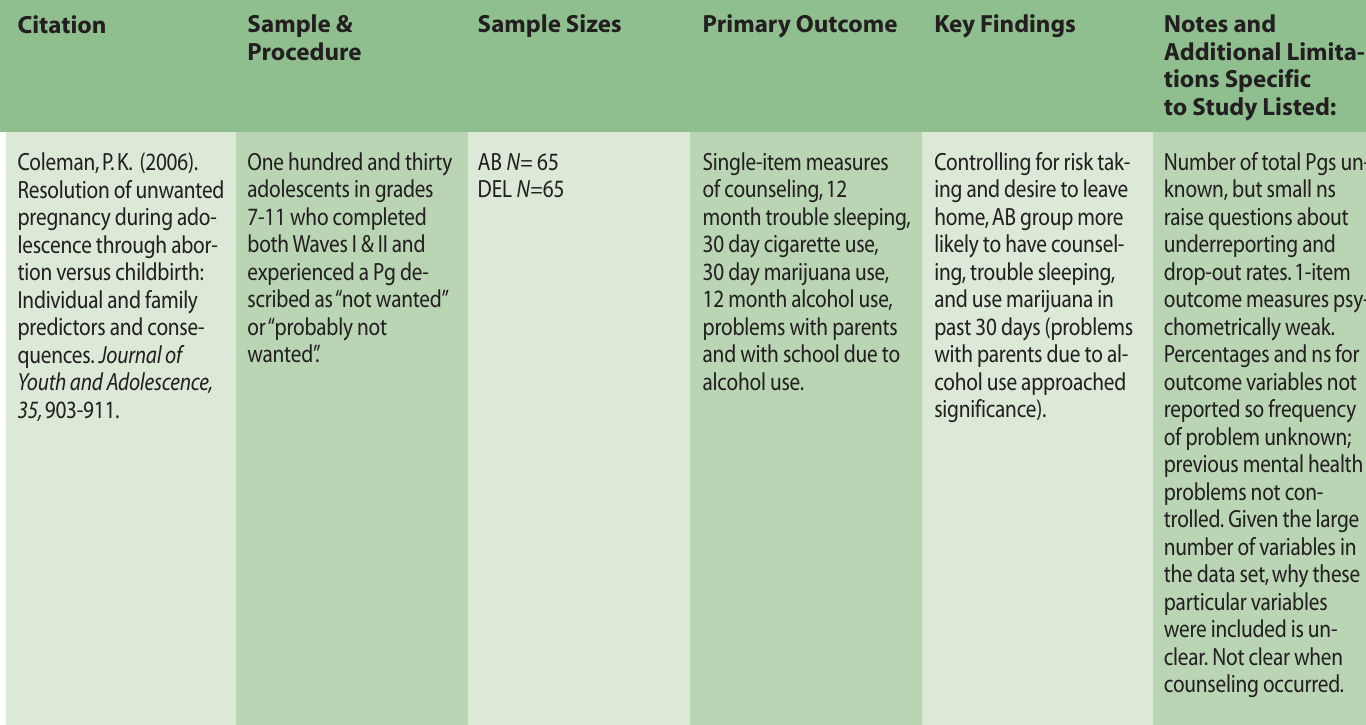
Table 2: Secondary Analyses of Survey Data–Abortion vs.Comparison